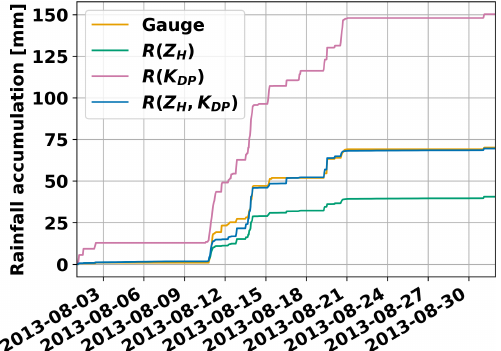
Figure 3. The 1-month 1h rainfall cumulative accumulations for Sürgavere radar data and Tartu-Tõravere station gauge data. Z H is not corrected for